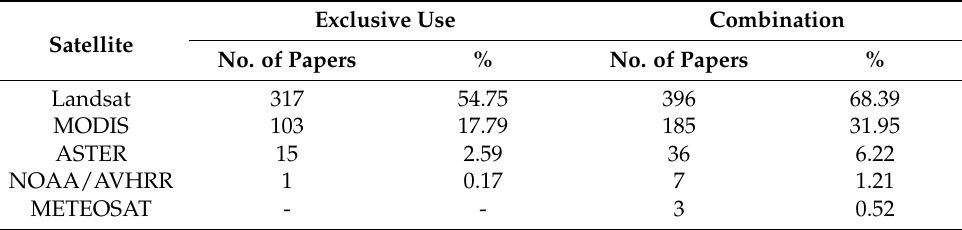
Table 6. Most used satellites/sensors to obtain LST